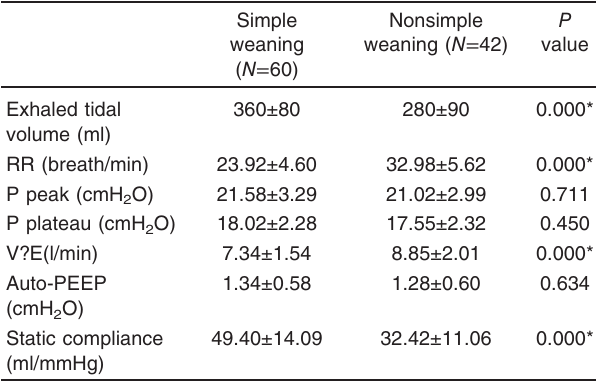
Table 2 Ventilator parameters at the end of the first spontaneous breathing trial Simple